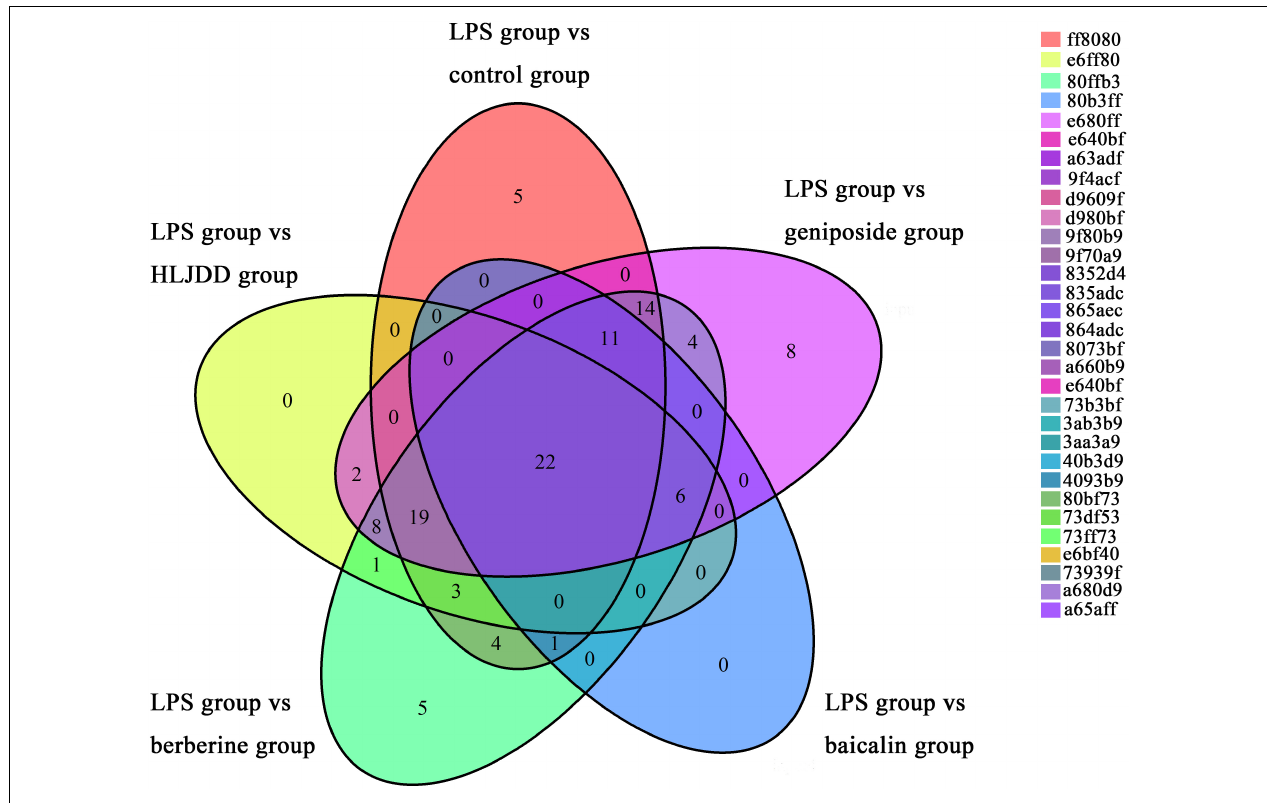
FIGURE 6 | Venn diagram, in which each ellipse represents the potential lipid markers based on comparisons of the lipopolysaccharide (LPS) group vs. drug treatment groups and LPS group vs. the control group.